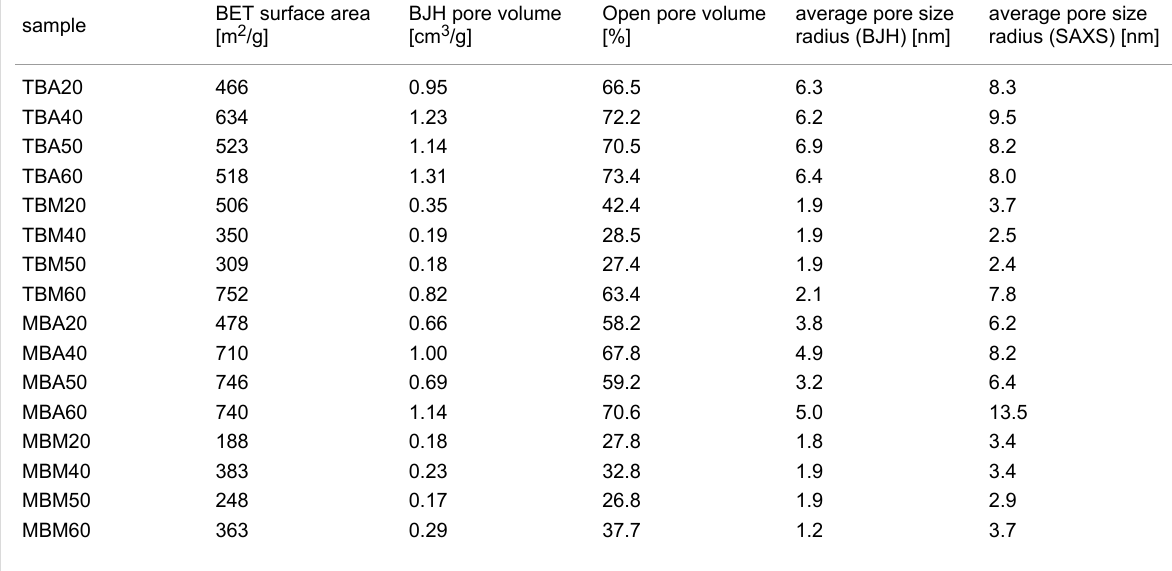
Table 1: Surface areas, pore volumes, porosity, and BJH average pore sizes derived from SAXS and nitrogen sorption (BET).